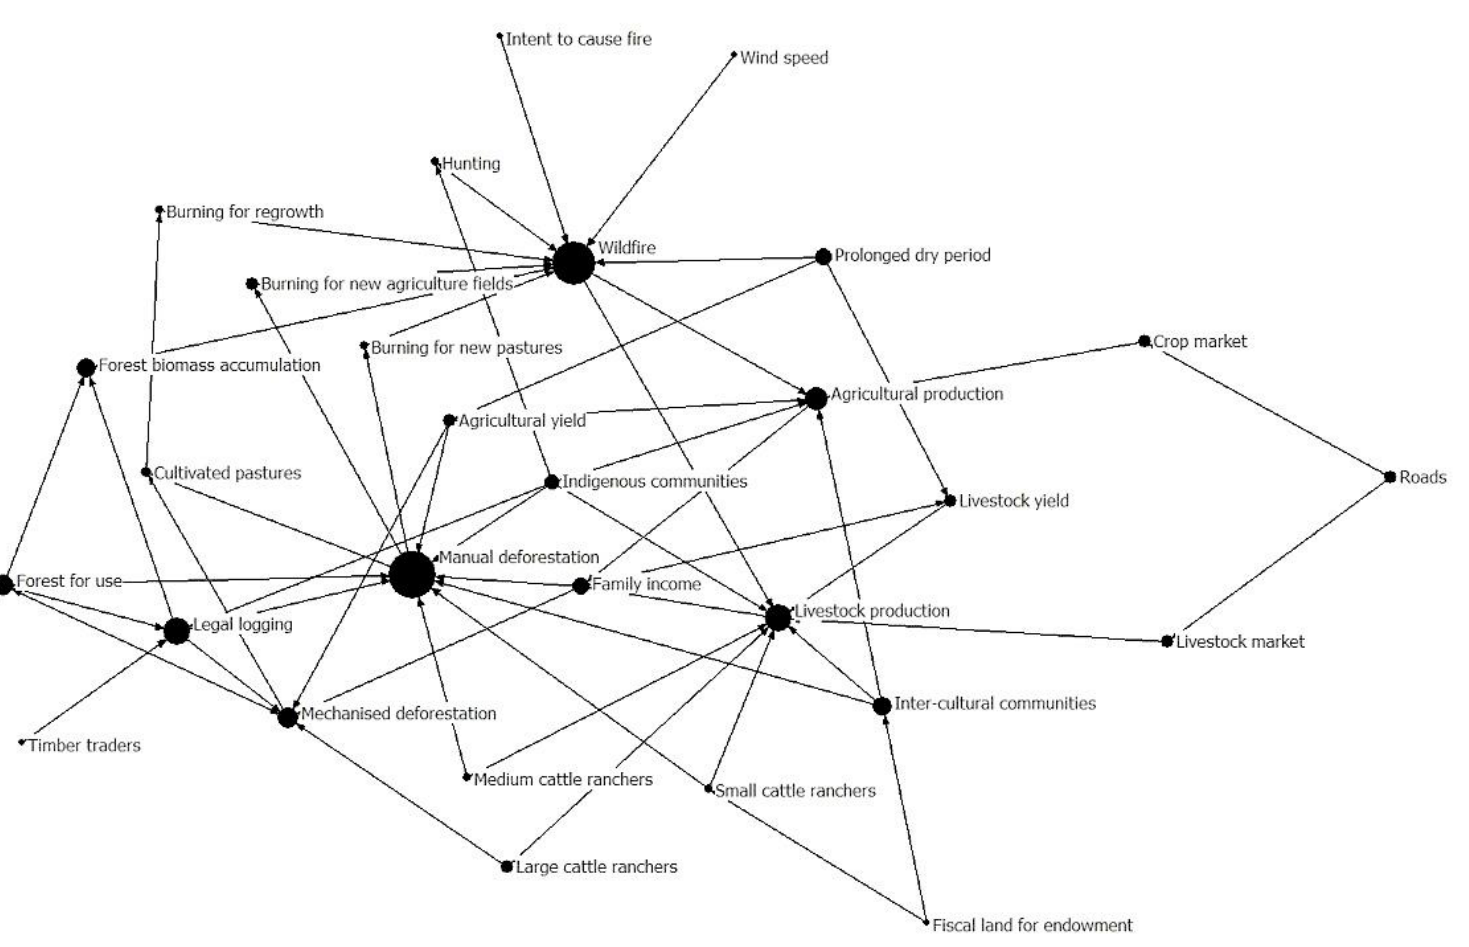
Fig. A6.2. Network showing the FCM developed in Concepción by the local authorities. Variables with higher degree centrality are presented as larger nodes. Edge weights are not visualized to help